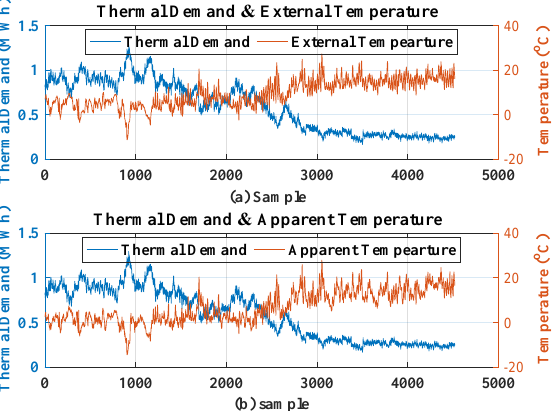
Figure 6. ( a ) Graph of thermal demand and external temperature; ( b ) thermal demand and apparent temperature.